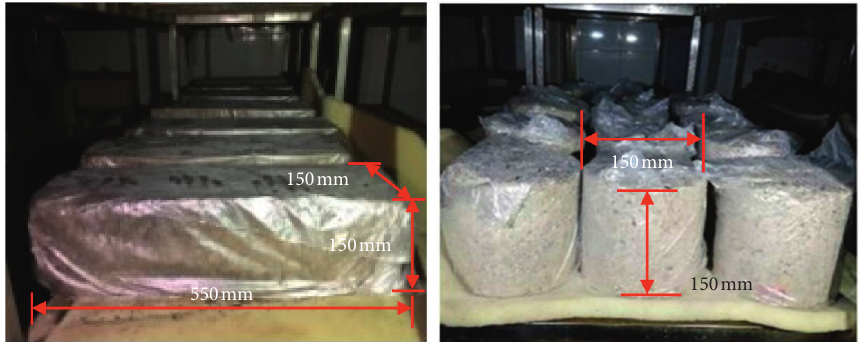
Figure 2: Preparation of cement-treated aggregate specimens.